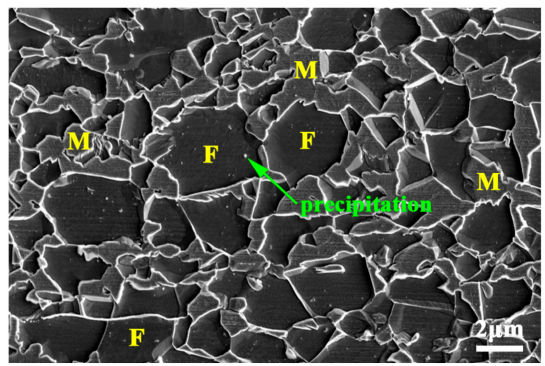
Figure 5. High-magnification SEM micrograph of UFG-DP steels.